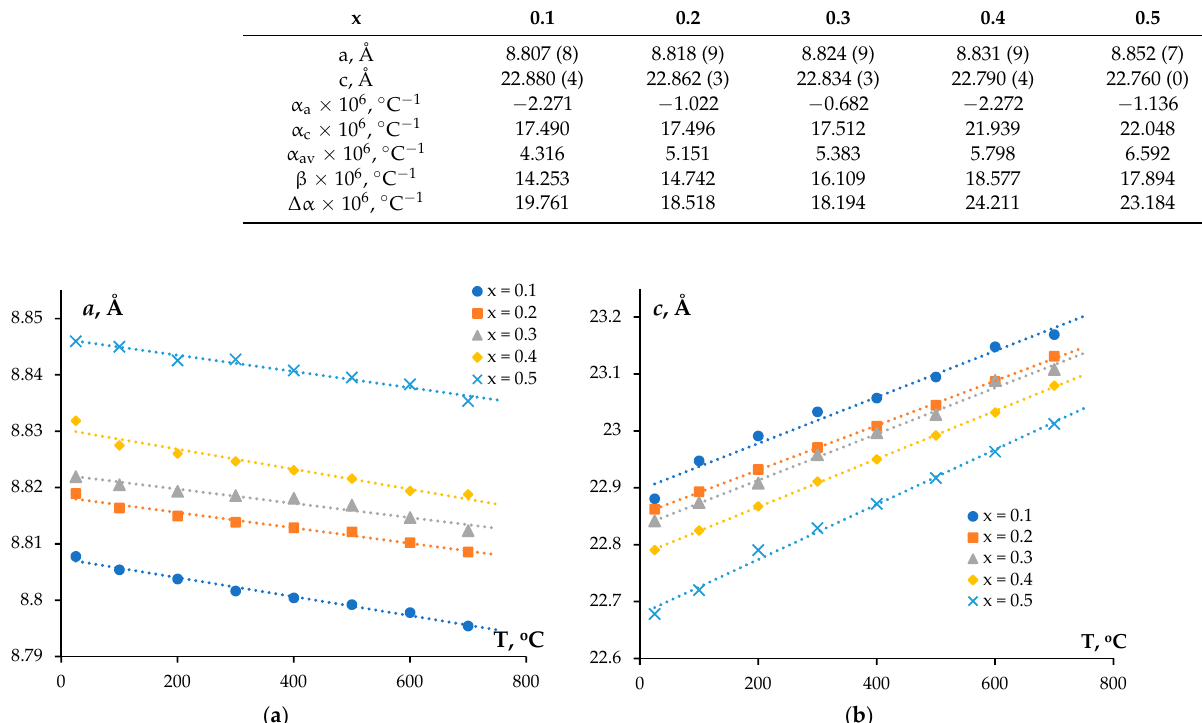
Figure 5. Temperature dependences of crystal lattice parameters a ( a ) and c ( b ) of Na 1+2x Zr 2- x Co x (PO 4 ) 3 compounds. Table 1. Lattice parameters and thermal expansion parameters of Na 1+2x Zr 2-x Co x (PO 4 ) 3 phosphates.